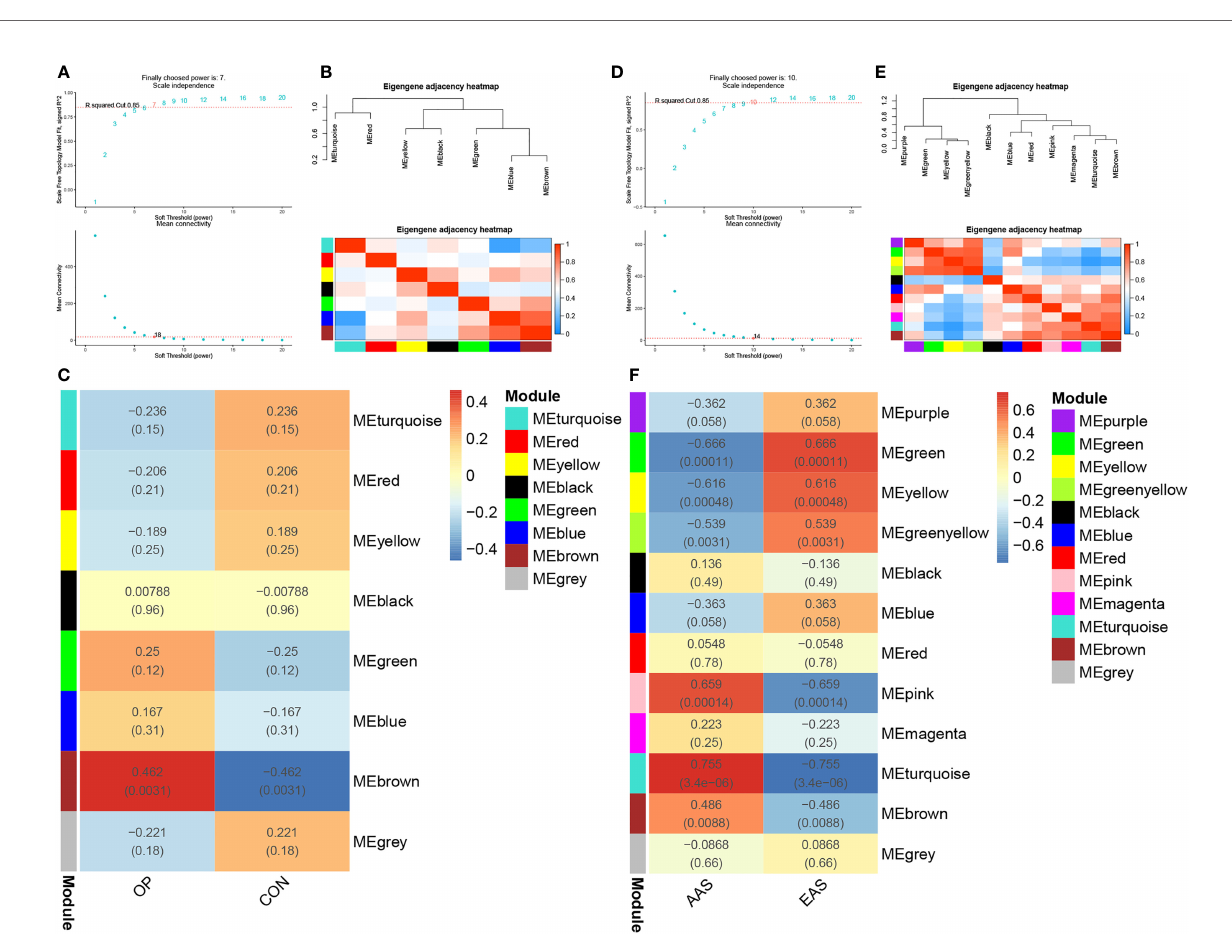
FIGURE 2 | Weighted genes correlation network analysis (WGCNA) of GSE56815 and GSE28829 datasets. (A) Soft threshold analysis in osteoporosis. (B) Module correlations in osteoporosis. (C) Heatmap of the module – trait relationship in osteoporosis. Each cell contains the corresponding correlation and P -value. (D) Soft threshold analysis in atherosclerosis. (E) Module correlations in atherosclerosis. (F) Heatmap of the module – trait relationship in atherosclerosis. Each cell contains the corresponding correlation and P -value. OP, osteoporosis; CON, control; AAS, advanced atherosclerosis; EAS, early